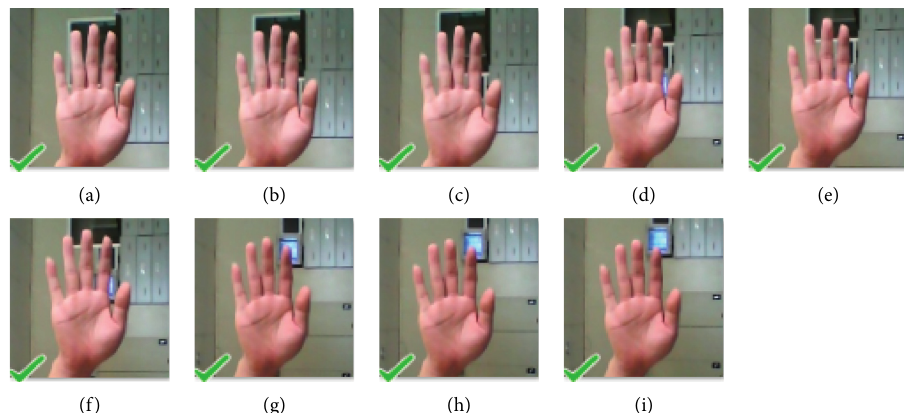
Figure 11: Several hand up datasets for training model. (a) 1239.jpg. (b) 1237.jpg. (c) 1235.jpg. (d) 1219.jpg. (e) 1217.jpg. (f) 1215.jpg. (g) 1199.jpg. (h) 1197.jpg. (i)